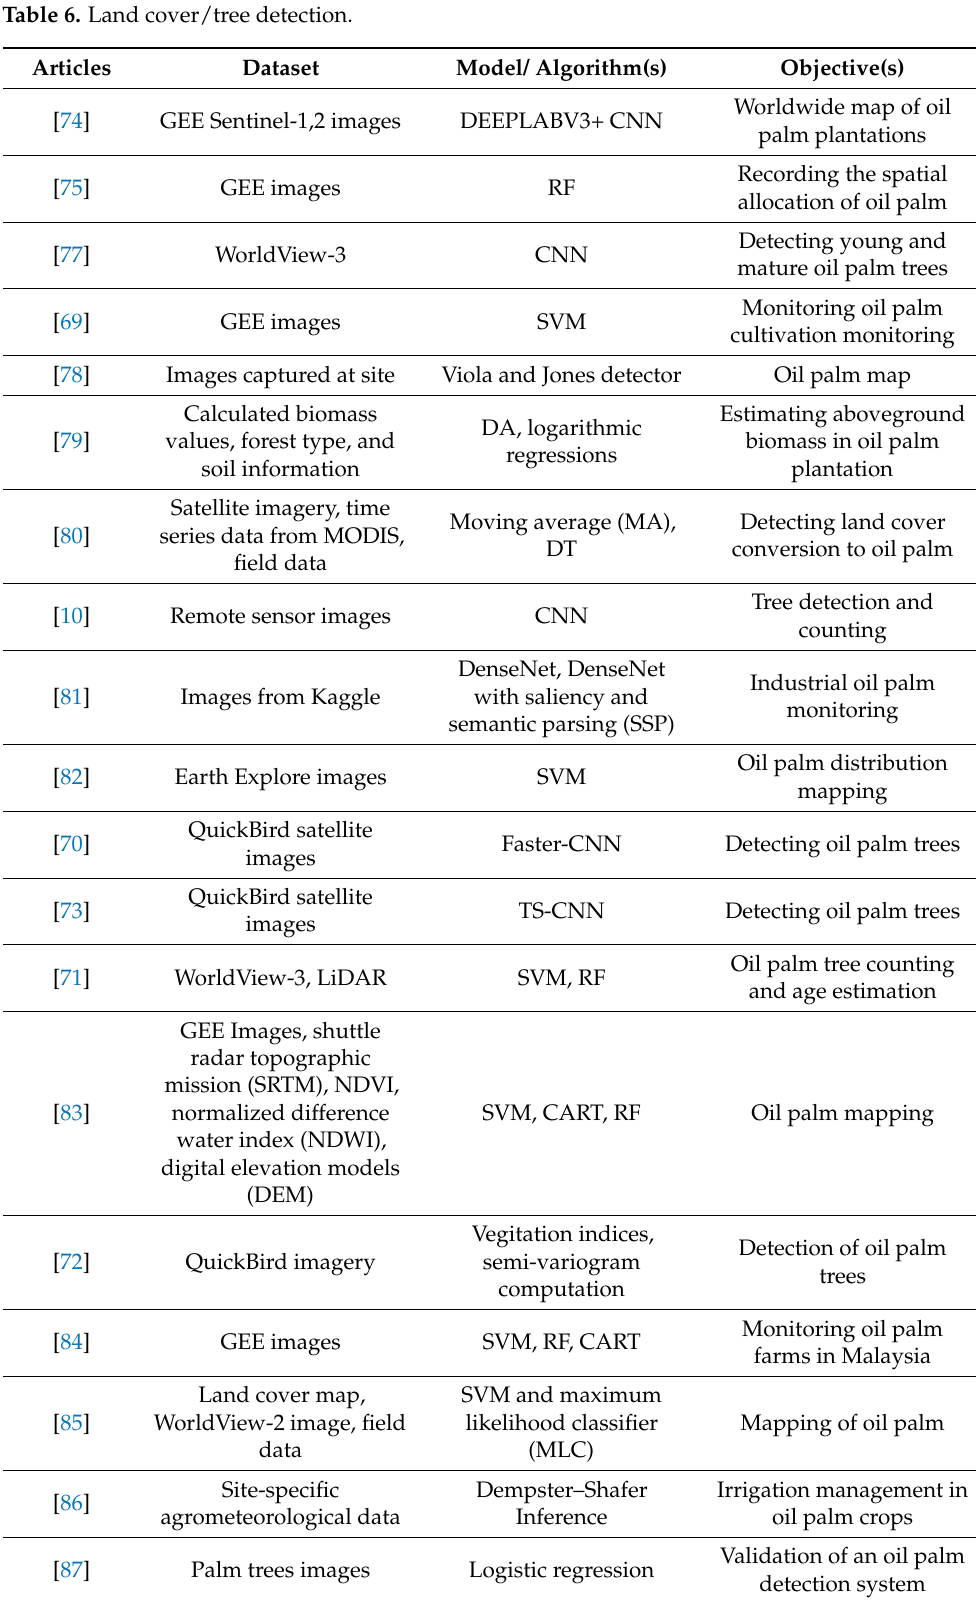
Table 6. Land cover/tree